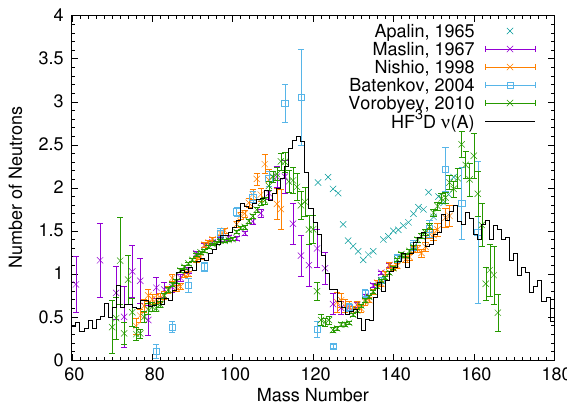
Figure 1. The mass dependent neutron multiplicity for 235 U(n th ,f) calculated with the HF 3 D model compared with experimental